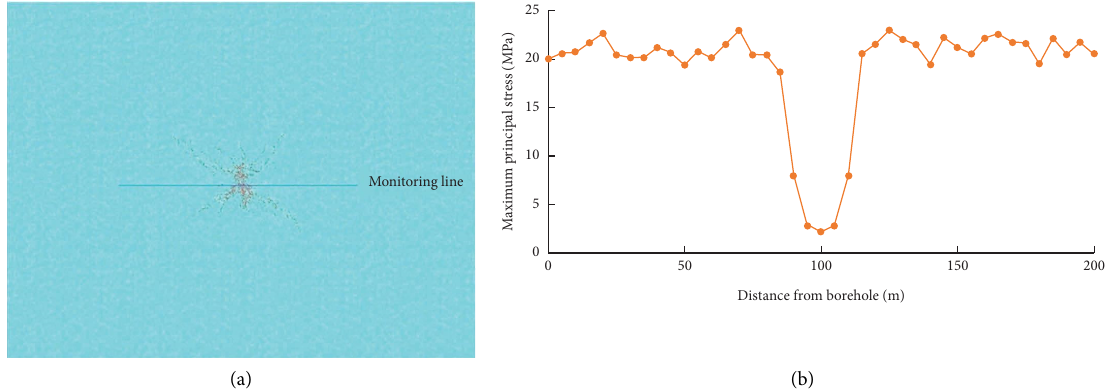
Figure 10: Fracture and stress distribution of 25MPa pressure fractured coal seam. (a) Distribution of fractures. (b) Stress distribution